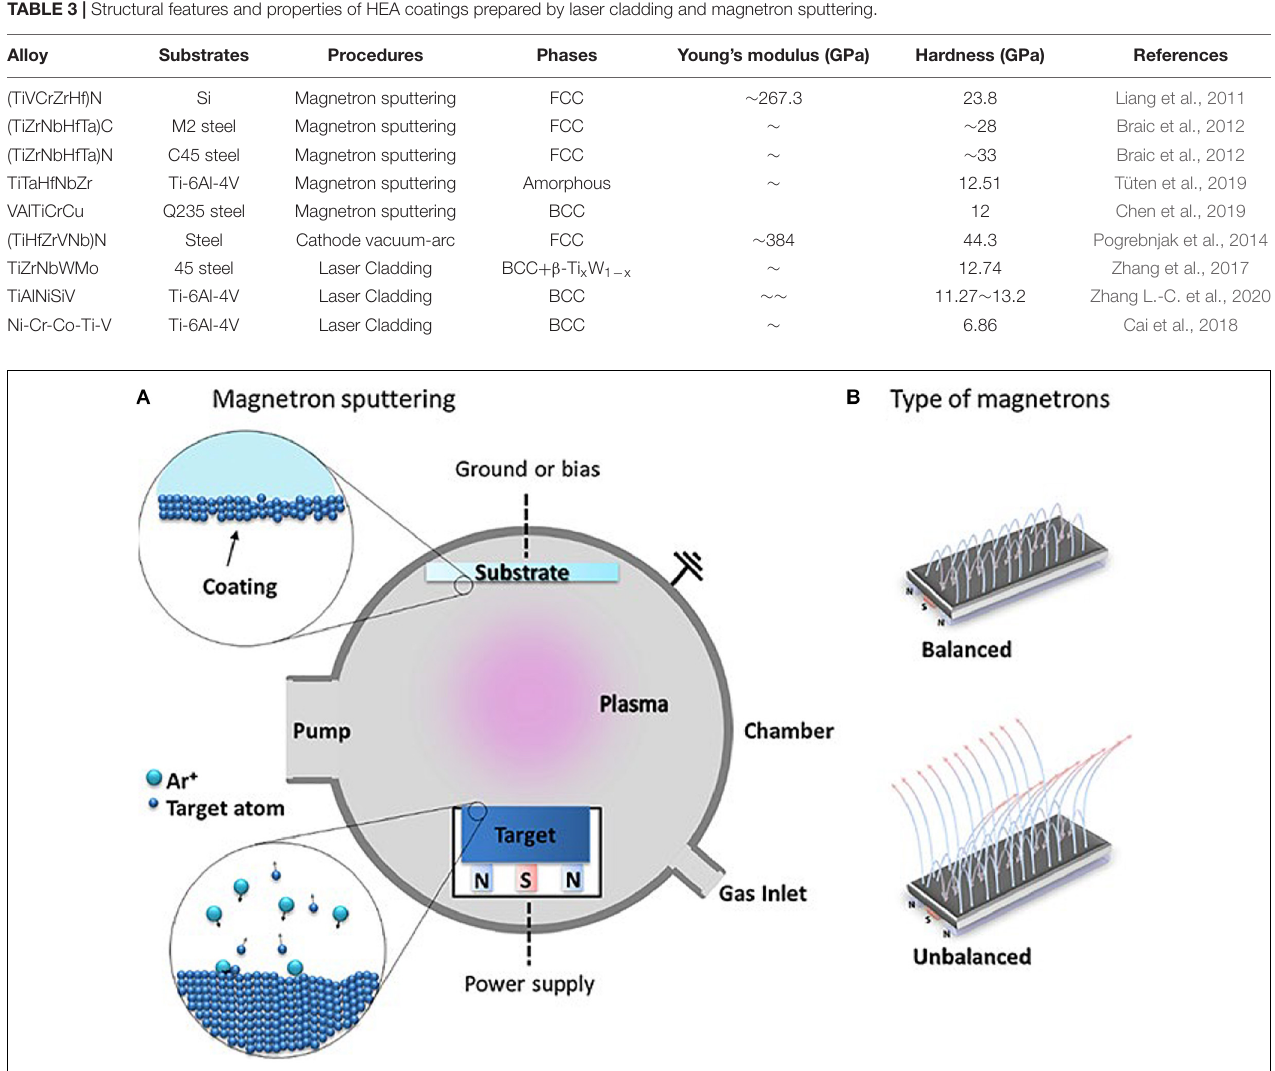
FIGURE 5 | (A) The schematic of magnetron sputtering, (B) balanced and unbalanced types of magnetron configurations used in MS (Calderon Velasco et al., 2016). Reproduced from Calderon Velasco et al. (2016) with